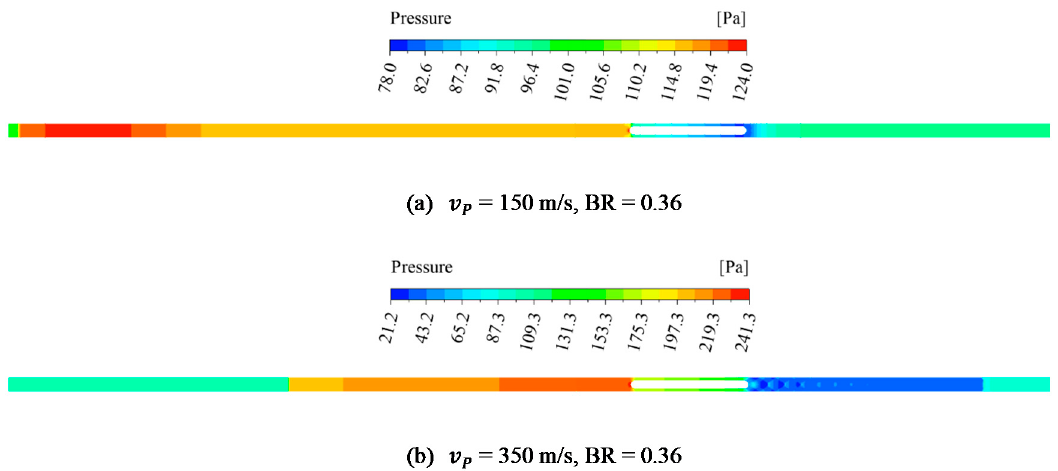
Figure A4. Pressure contour of pressure waves generated at the front and rear of the pod. The largest red regime describes the high-pressure regime.